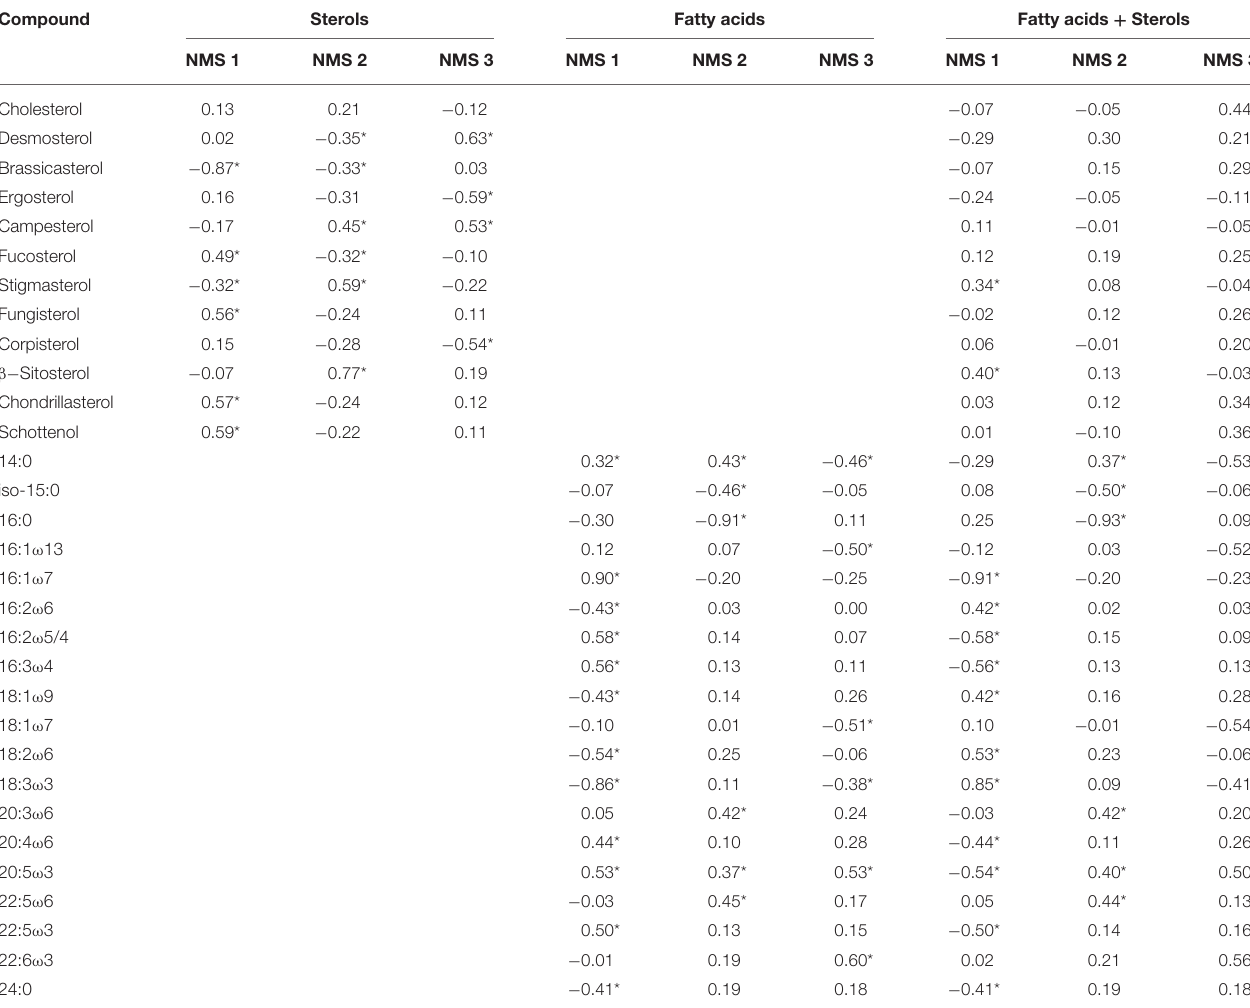
TABLE 6 | Pearson correlations between individual fatty acids and sterols and the NMS axes 1, 2, and 3. Compound Sterols Fatty acids Fatty acids +